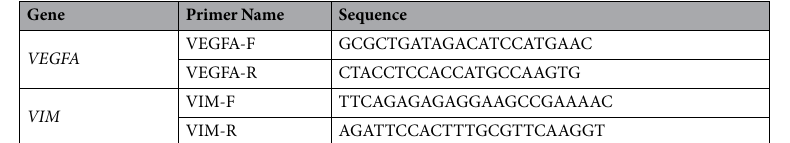
Primary Antibody Company